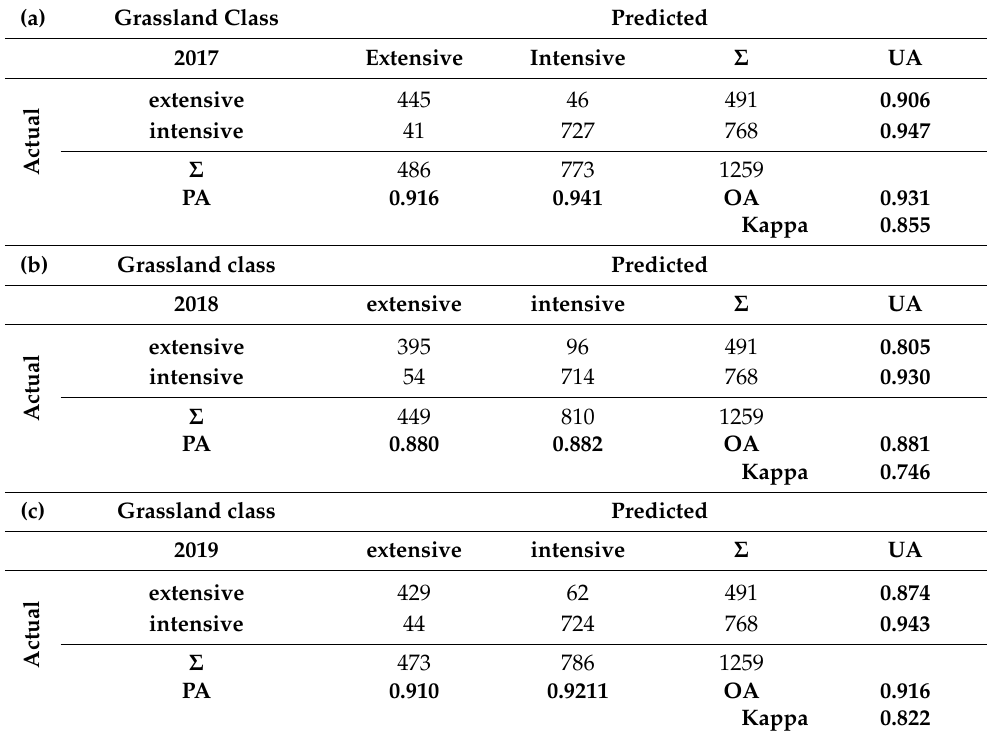
Table 6. Confusion matrices of the annual SITS (using the best feature selection with MDA from Sentinel-1, Sentinel-2 and environmental data) for the accuracy of the reference dataset with RF classifier (UA: User’s Accuracy, PA: Producer’s Accuracy, OA: Overall Accuracy). ( a ) is for the year 2017, ( b ) for 2018 and ( c ) is for